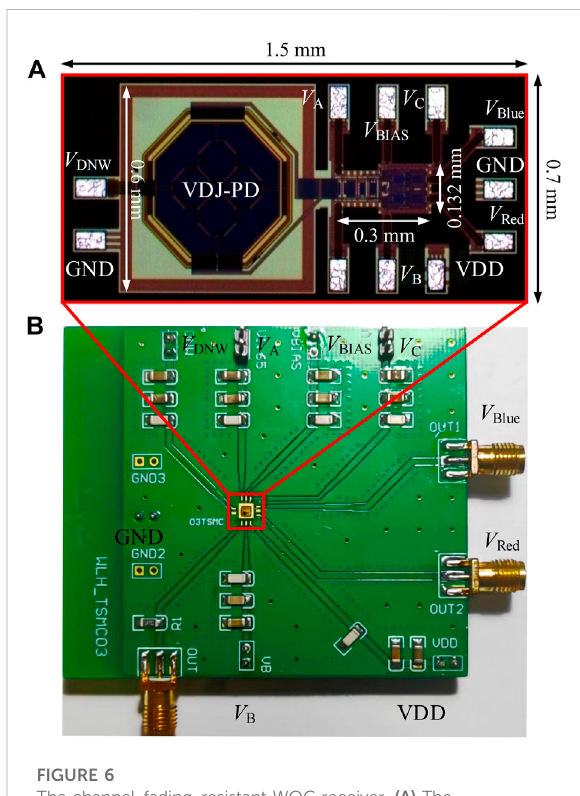
FIGURE 6 The channel-fading-resistant WOC receiver. (A) The micrograph of the receiver; (B) The test PCB of the receiver.